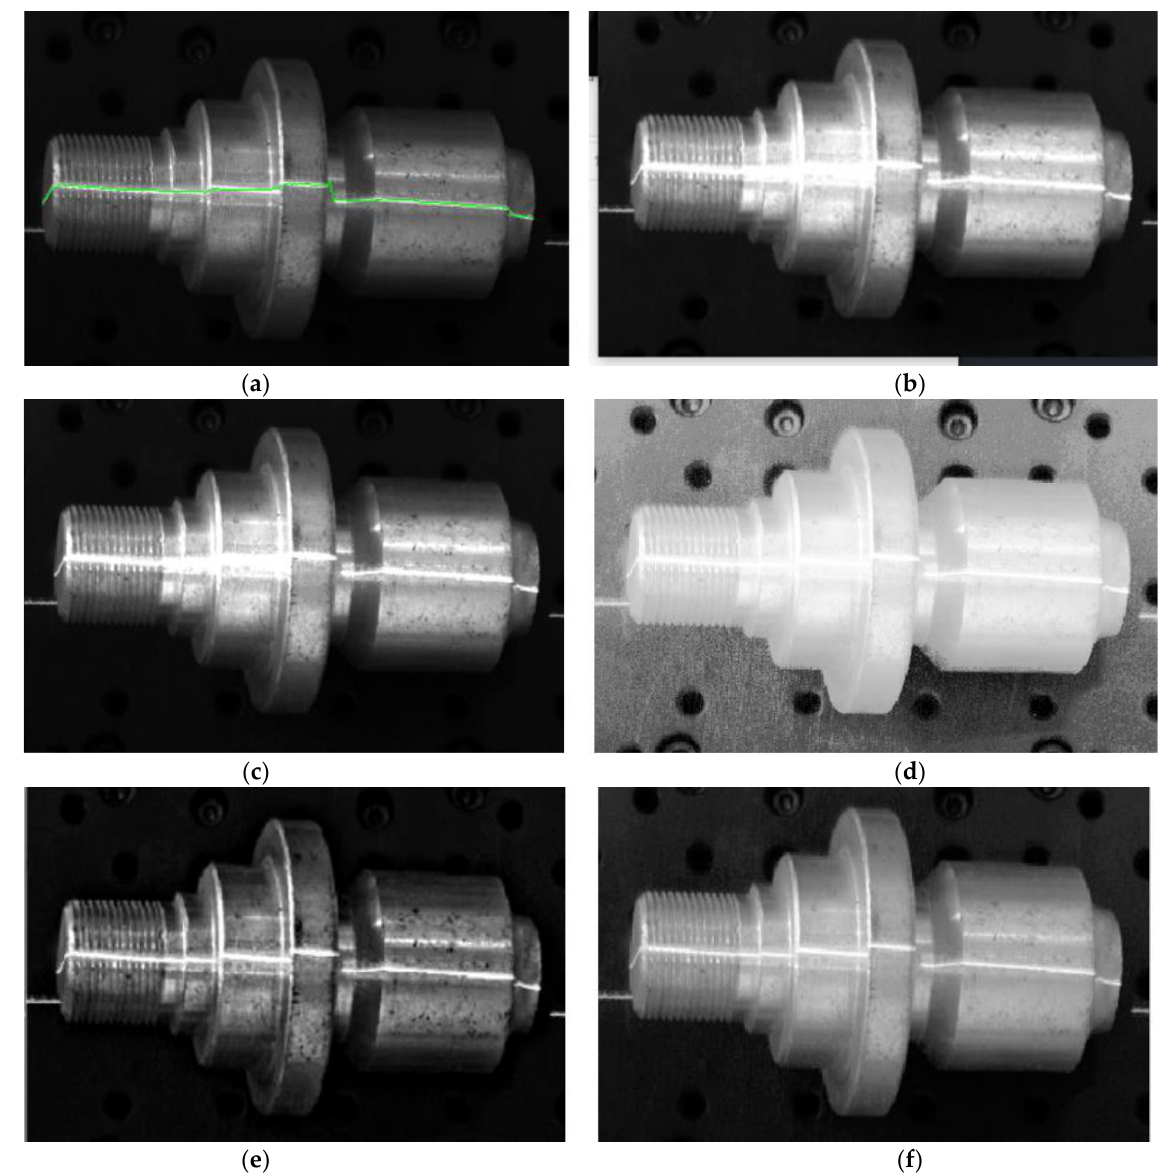
Figure 15. Comparison of different algorithms for metal roller processing: ( a ) the algorithm of this paper; ( b ) ref. [24] algorithm; ( c ) ref. [25] algorithm; ( d ) ref. [26] algorithm; ( e ) ref. [27] algorithm; ( f ) ref. [28] algorithm.